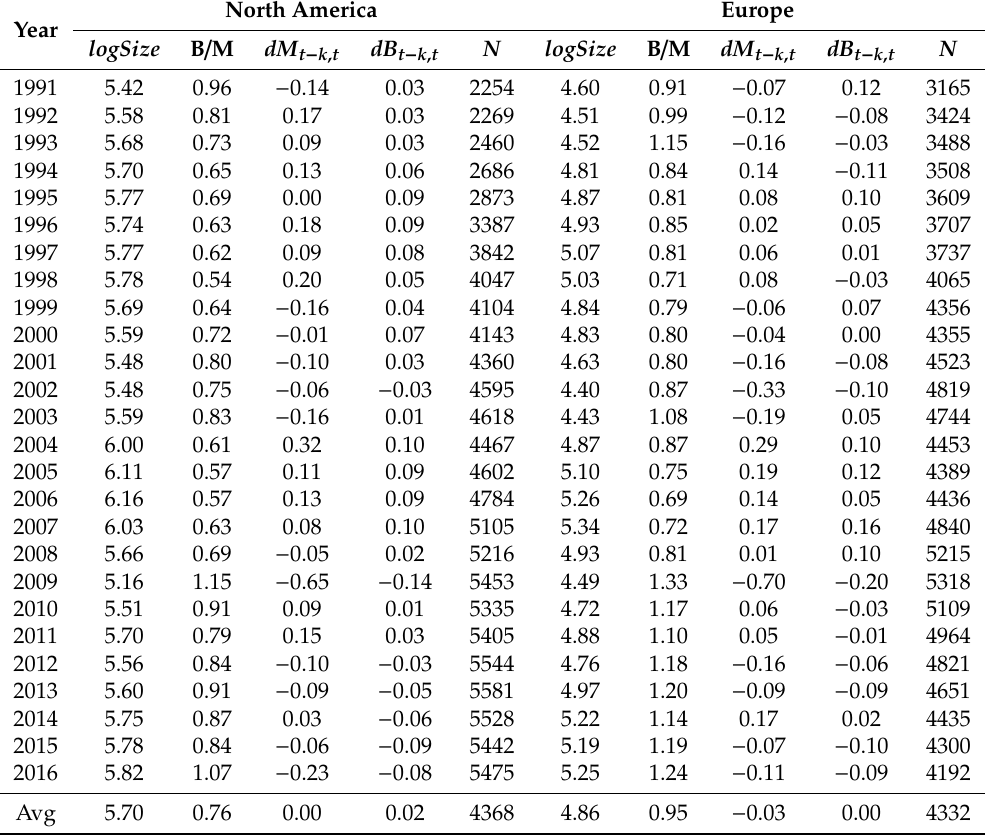
Table A1. Descriptive Statistics. Twenty-three global markets are divided into the regions of